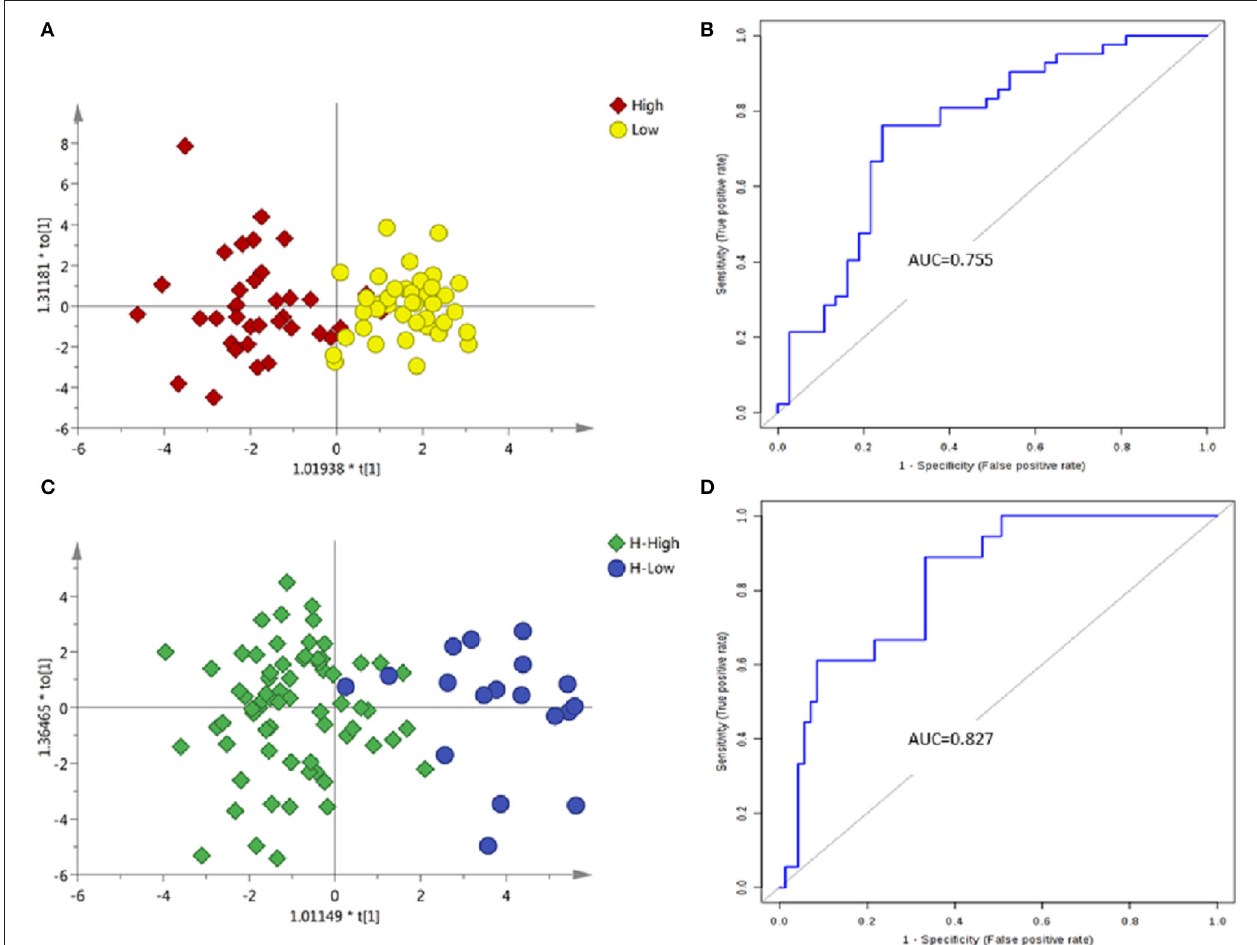
FIGURE 4 | Analysis of metabolic profiling in low- and high-grade NMIBC. (A) Score plot of OPLS-DA model based on metabolome between low- and high-grade NMIBC without hematuria. (B) ROC plot based on model to quantify the discrimination degree of NMIBC grading without hematuria. (C) Score plot of OPLS-DA model based on metabolome between low- and high-grade NMIBC with hematuria. (D) ROC plot based on model to quantify the discrimination degree of NMIBC grading with